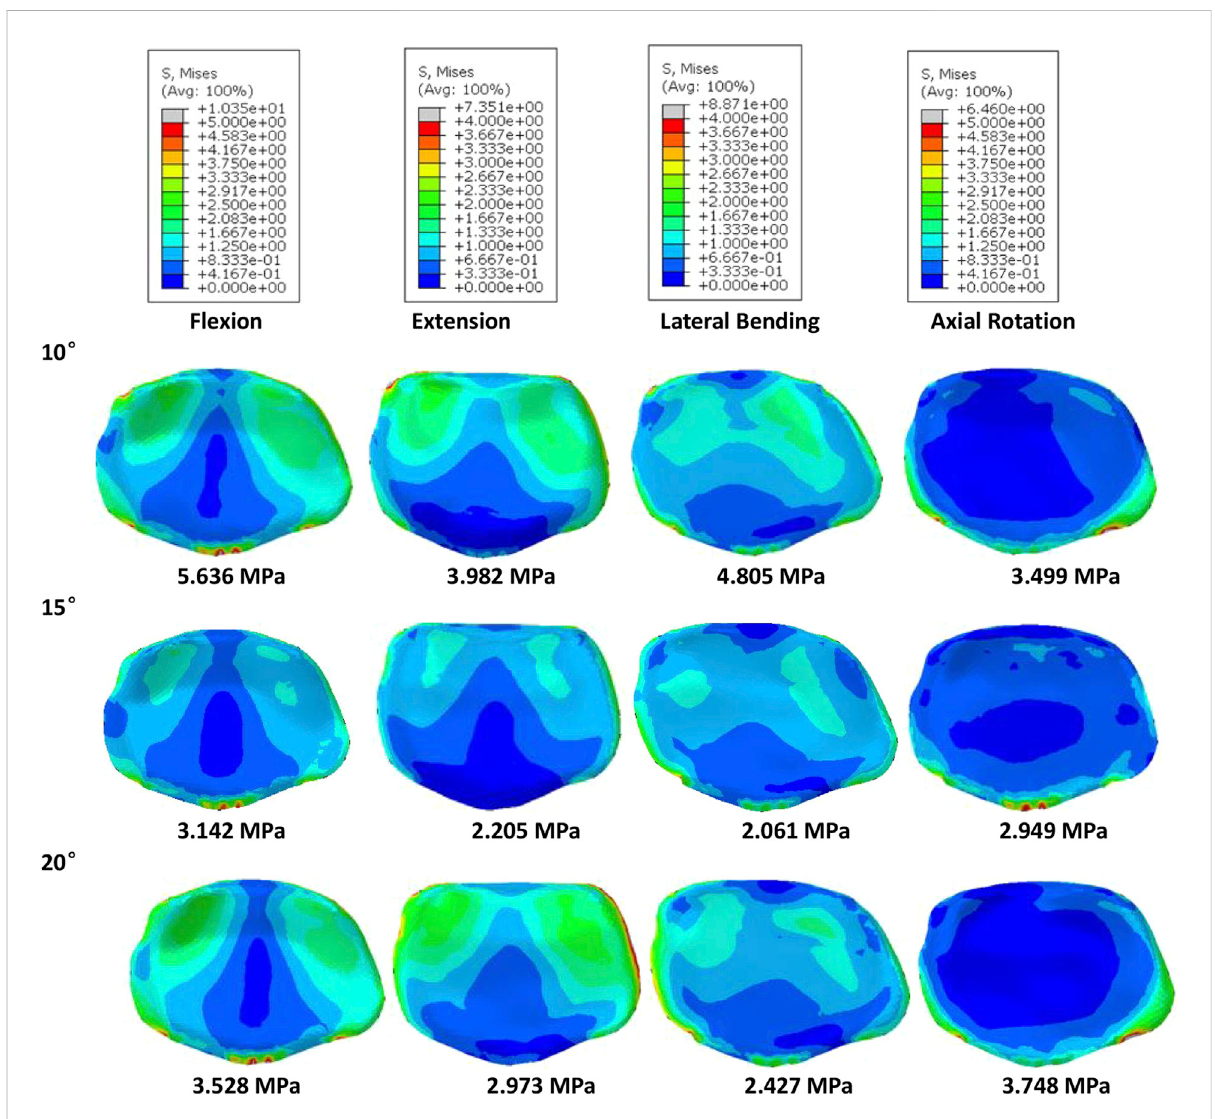
FIGURE 4 Von-Mises stress on the L4 endplate of the models for different screw inclination angles when placed under fl exion, extension, lateral bending, and axial rotation, with the mean stress noted beneath each